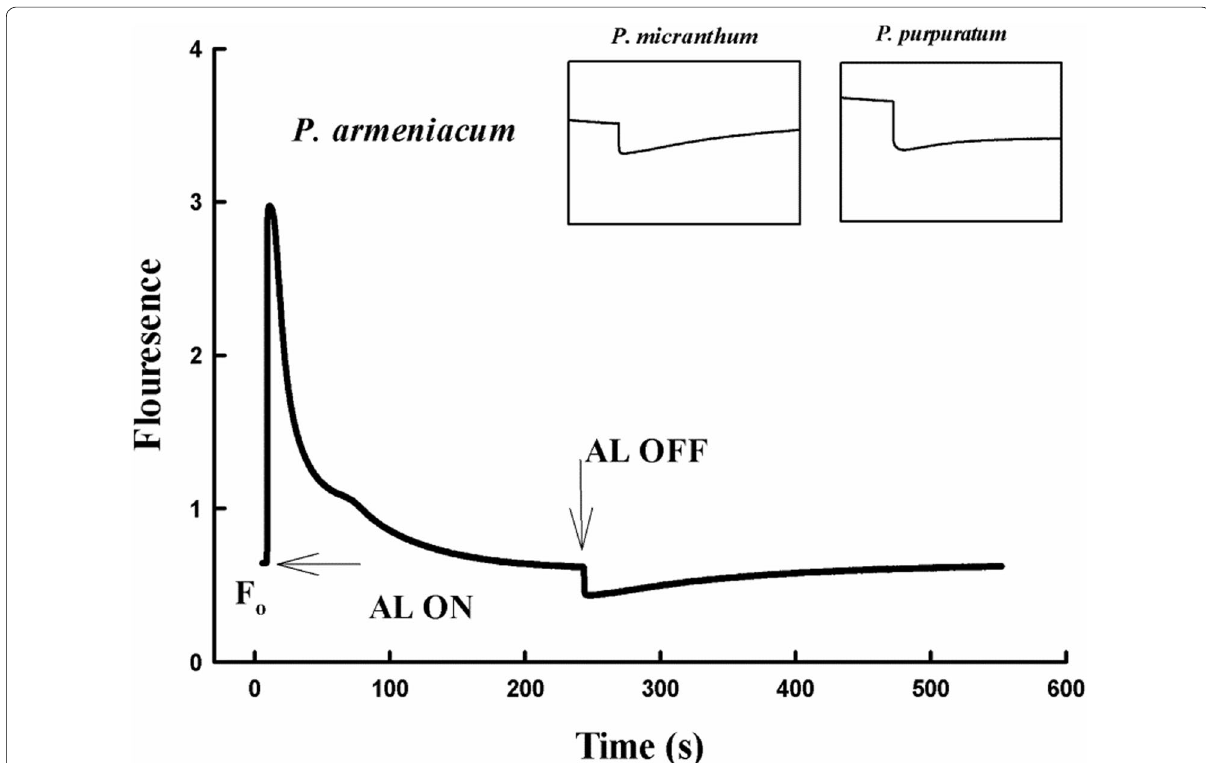
Fig. 8 Monitoring of NDH activity by chlorophyll fluorescence. Mature leaves of three Paphiopedilum species were exposed to actinic light (AL, 200 μmol photons m − 2 s − 1 ) after the measuring light was turned on (Fo, the minimum level of chlorophyll fluorescence). The AL was turned off and the subsequent change in chlorophyll fluorescence was monitored as an indicator of NDH activity. The mature leaf was dark‑adapted at 25 °C for 30 min, and the chlorophyll fluorescence was measured at 25